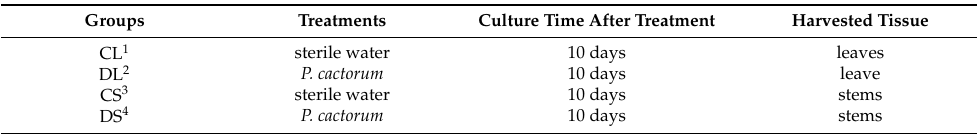
Table 1. Treatments of ginseng plant in different groups. Groups Treatments Culture Time After Treatment Harvested Tissue CL 1 sterile water 10 days leaves DL 2 P. cactorum 10 days leave CS 3 sterile water 10 days stems DS 4 P. cactorum 10 days